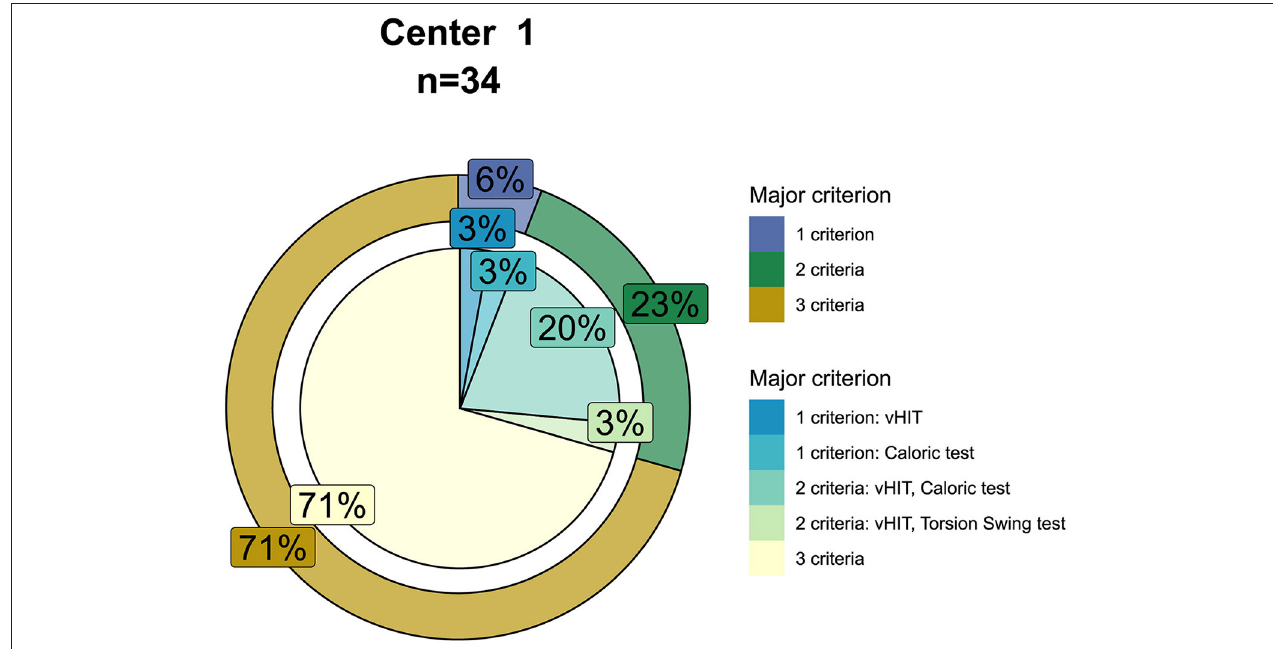
FIGURE 7 | Seventy-six percent of the patients met the criteria for vestibular implantation ( n = 34). For this group, the outer circle shows the percentages of patients meeting one, two, or three of the major implantation criteria (i.e., for caloric testing bilateral impaired caloric responses with a sum of bithermal maximal peak slow phase velocity ≤ 6 ◦ /s, for torsion swing test a reduced VOR gain ≤ 0.1 and for vHIT a bilaterally reduced horizontal VOR gain ≤ 0.6 combined with at least bilaterally one vertical VOR gain < 0.7). The inner-circle shows the percentages of which tests are met by patients meeting one or two of the major implantation